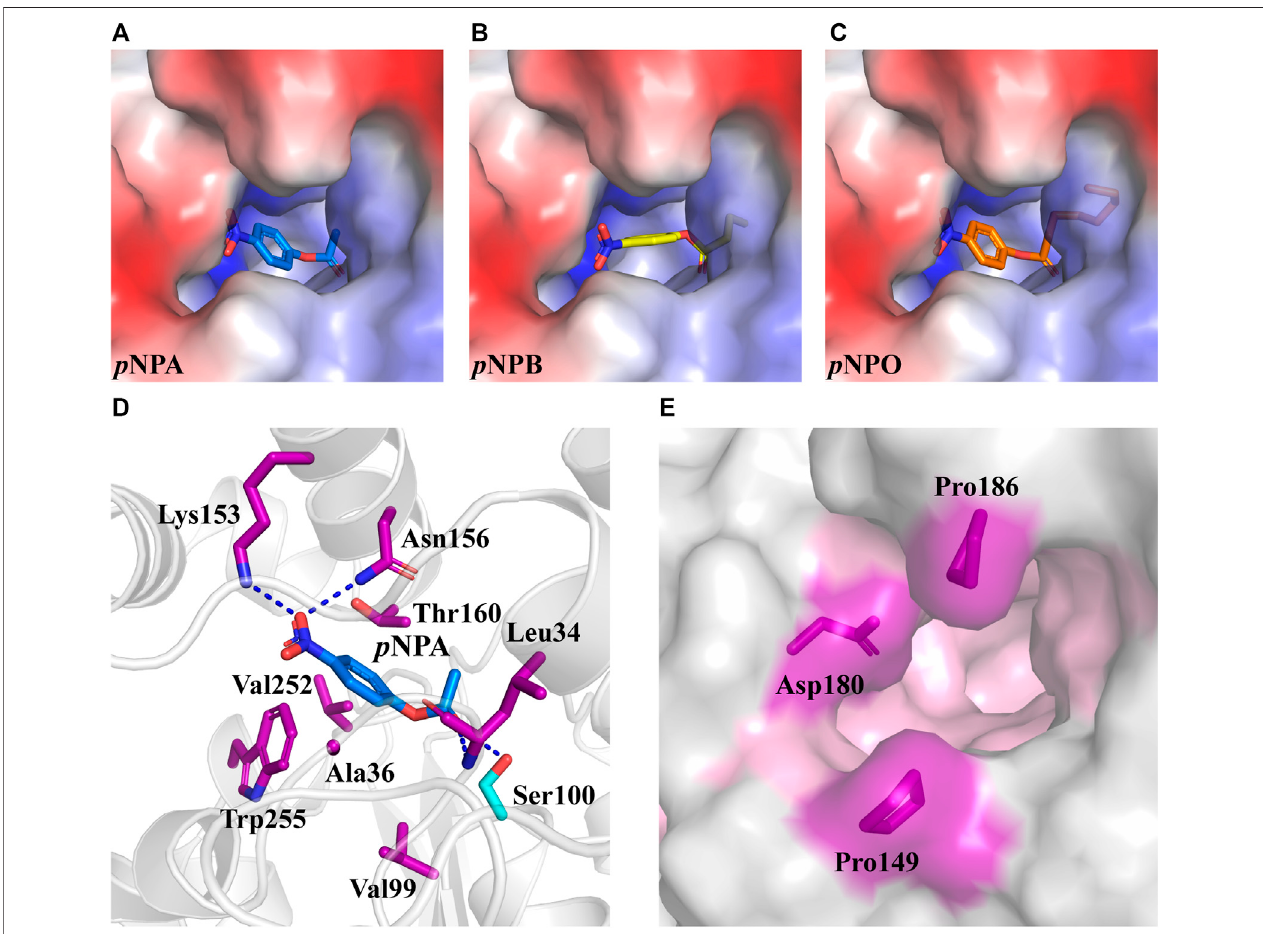
FIGURE 5 | The optimal conformation of p NPA, p NPB and p NPO docking in Df FAE. (A – C) Df FAE is shown as surface representation, colored by electrostatic potentials(positive, blue; negative,red). p NPA (A, blue), p NPB(B, yellow)and p NPO (C, orange) are shown assticks. (D) Cartoon representation of p NPA binding tothe active site of Df FAE. The catalytic Ser100 is shown as a cyan stick, and other interacting residues are shown as purple sticks. Hydrogen bonding forces are shown as bluedashedlines (E) Surfacerepresentationofmutationsitesattheentranceofbindingpocket.Thebindingpocketareacoloredinpink,mutationsiteresiduesare shown as purple